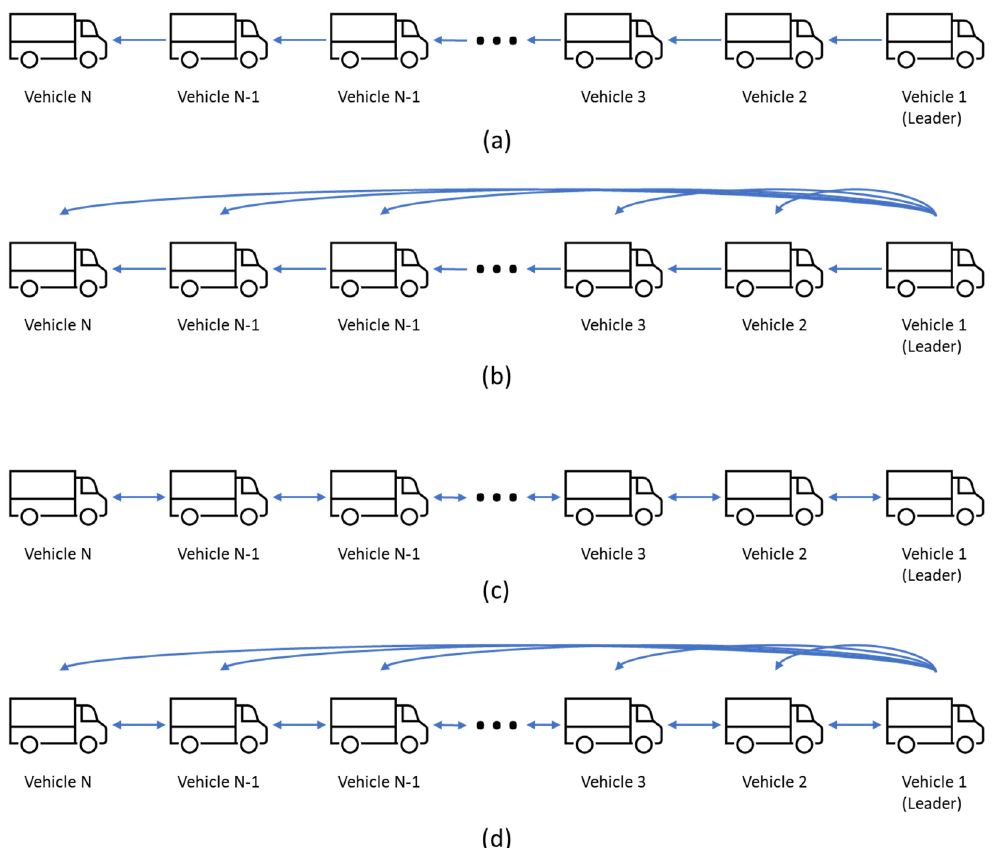
Figure 2. Common leader-follower communication topologies, adapted from [21]: ( a ) predecessor following; ( b ) predecessor-leader following; ( c ) bidirectional; ( d ) bidirectional-leader.